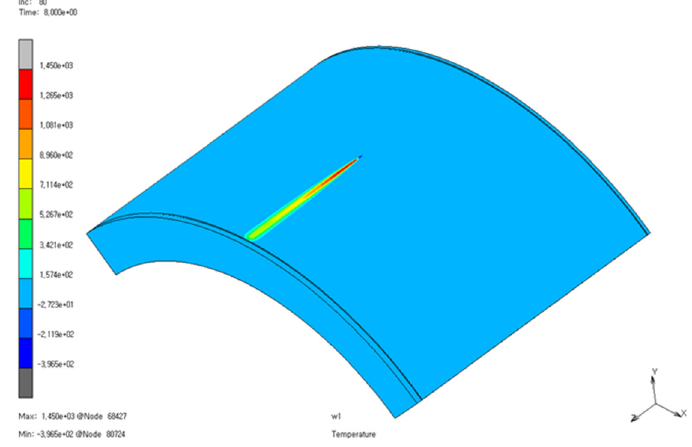
Figure 12. Welding temperature distribution at 8 s after welding started.